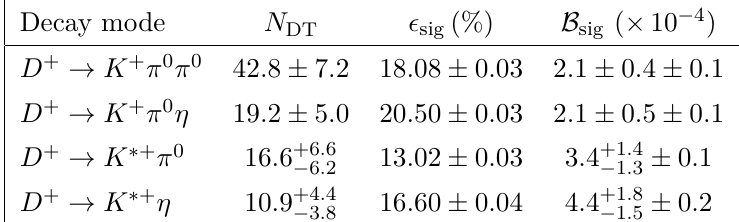
Table 2 . The DT yields in data ( N DT ), the signal efficiencies ( (cid:15) sig = (cid:15) i BFs. The first and second uncertainties are statistical and systematic, respectively. The efficiencies do not include the BFs of π 0 , η and K ∗ + decays. The lower efficiency for D + → K + π 0 π 0 is mainly due to the K 0 S